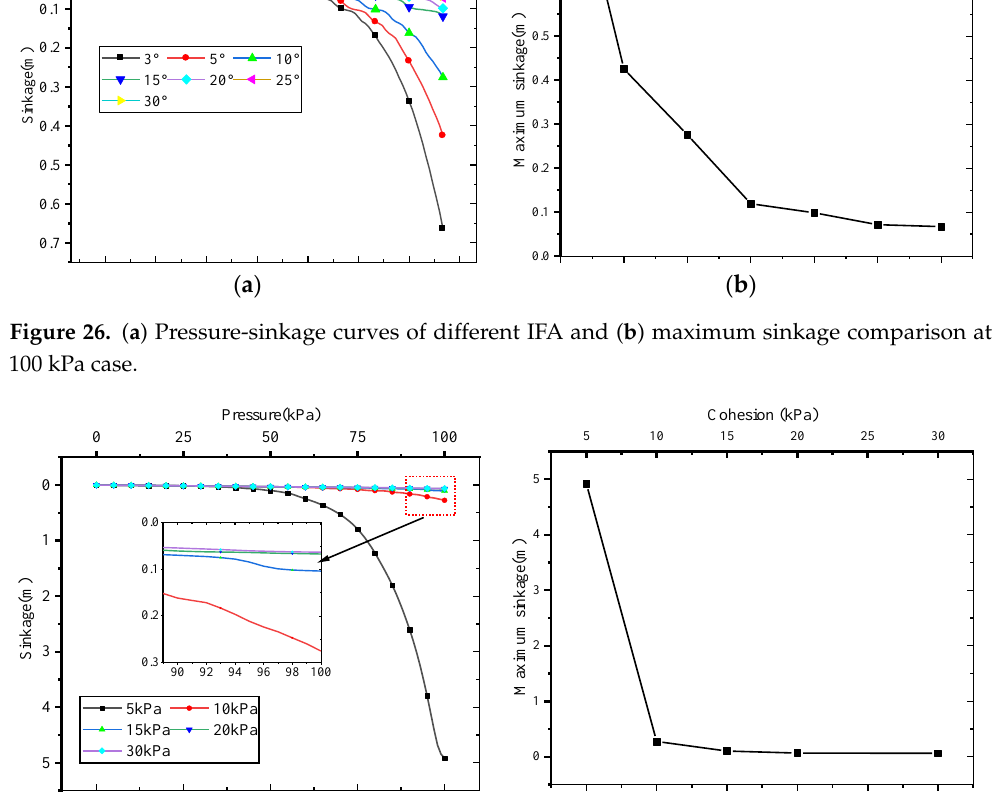
Figure 27. ( a ) Pressure-sinkage curves of different cohesion and ( b ) maximum sinkage comparison at 100 kPa case.